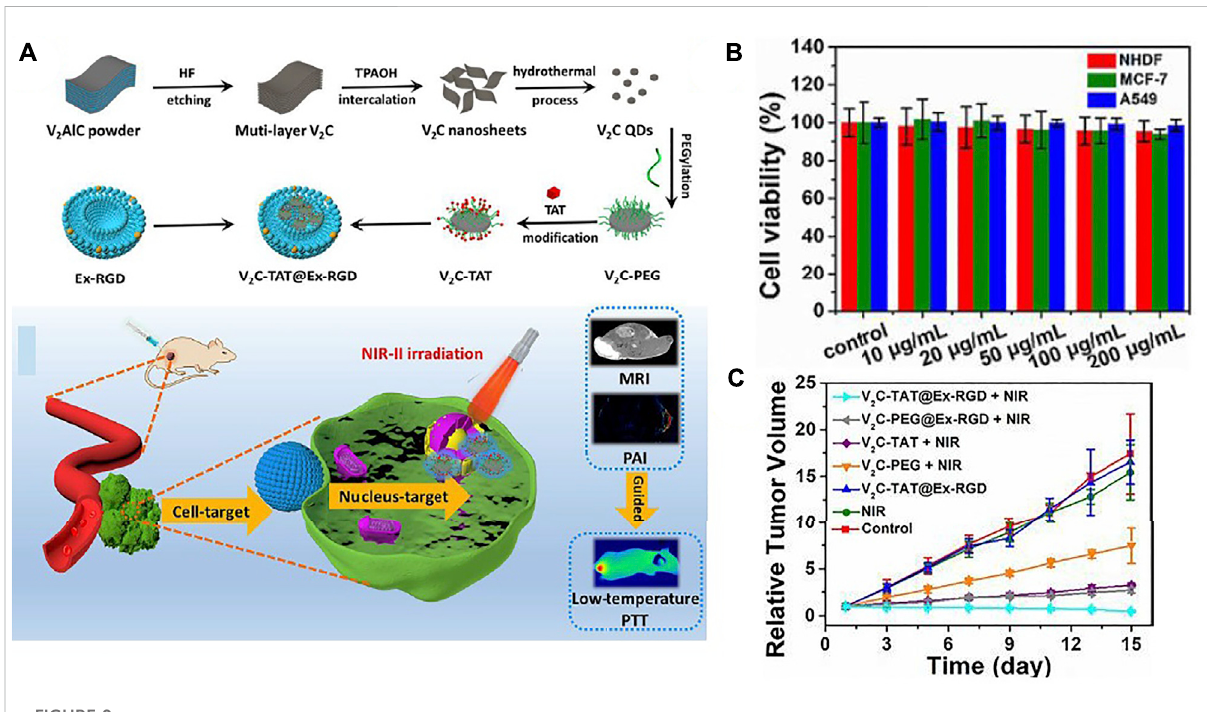
FIGURE 9 (A) The V 2 C-TAT@Ex-RGD preparation process and schematic of nuclear organ and cancer cell membrane with the dual objective of